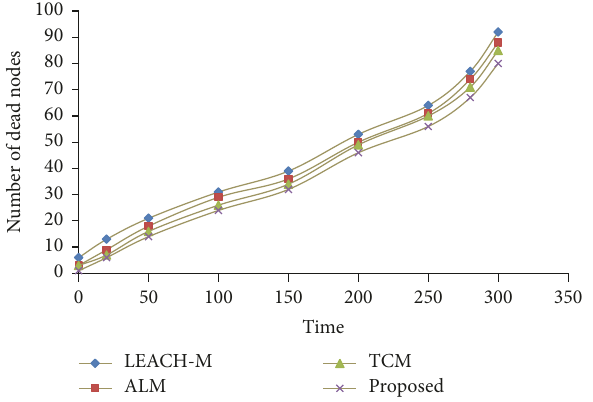
Figure 5: Number of dead nodes and time.